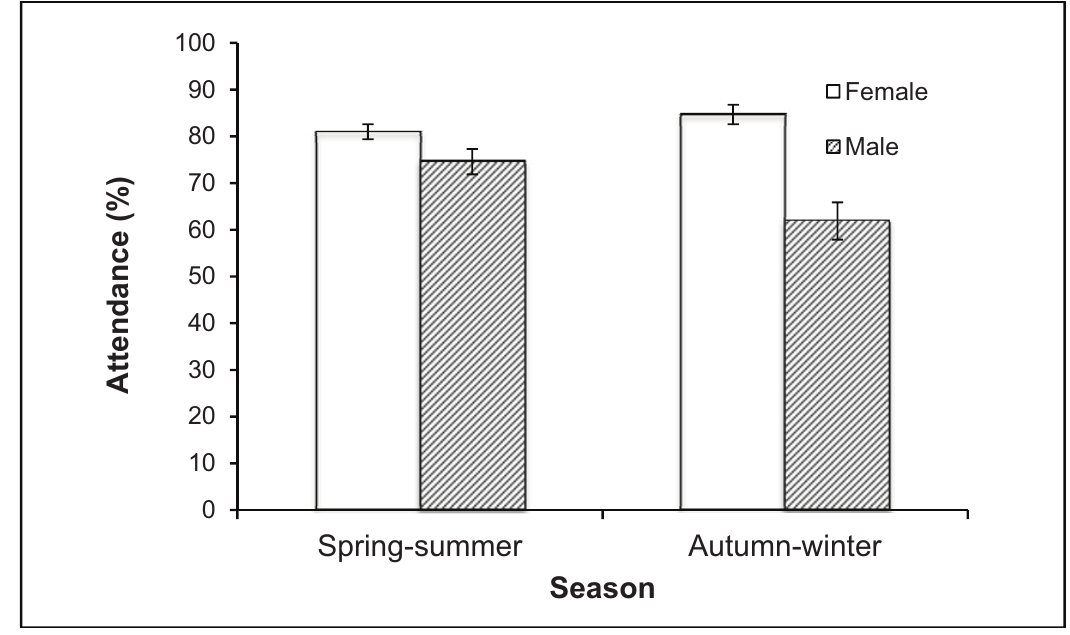
Figure 4. Mean attendance rate of individual male and female Eastern Grey Kangaroos Macropus giganteus (tagged as adults) in autumn/winter and spring/summer on the Anglesea golf course from May 2008 to November 2013. Data from censuses recording (cid:2)50 tagged adults (8 autumn/winter and 16 spring/summer), from the first census after each individual was tagged to the last in which it was known to be alive, excluding individuals spanning <10 censuses. Error bars show standard